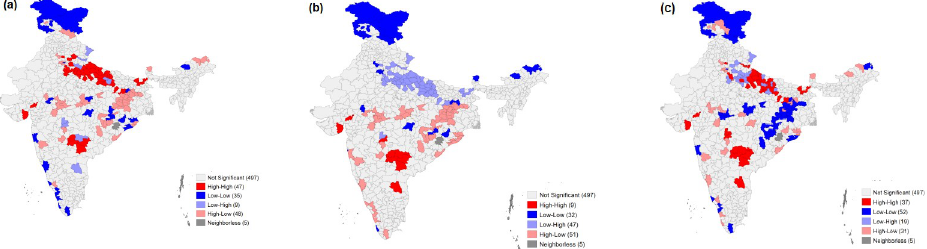
Fig 5. Bivariate LISA cluster maps showing the spatial clustering of stunting with a. Minimum meal frequency (MMF) b. Minimum dietary diversity (MDD) and c. Minimum acceptable diet (MAD) among children aged 6–23 months, India,